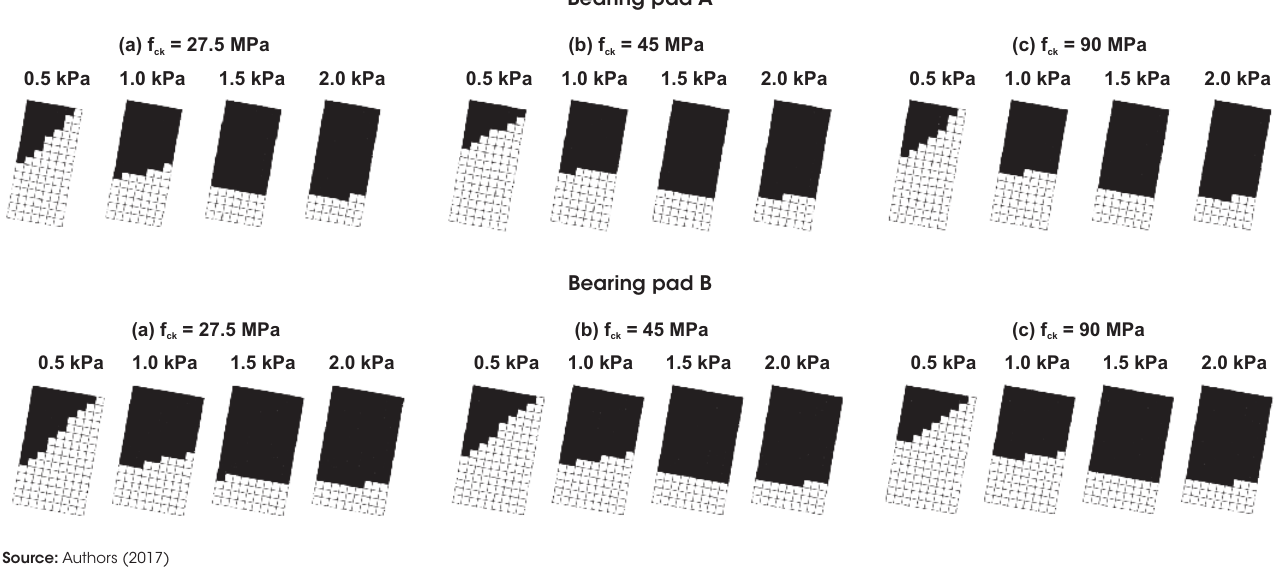
Loss of contact on the AASHTO beam Type IV on pad A and